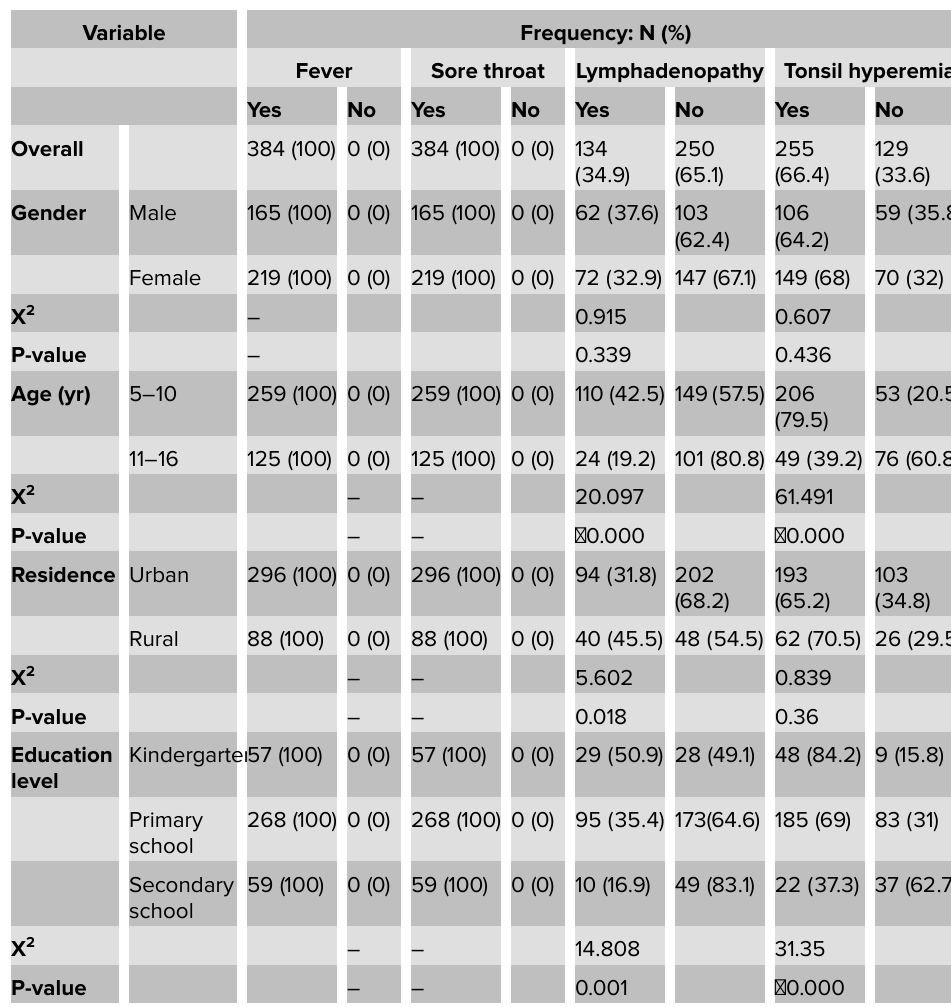
Table 2: Clinical features of the study